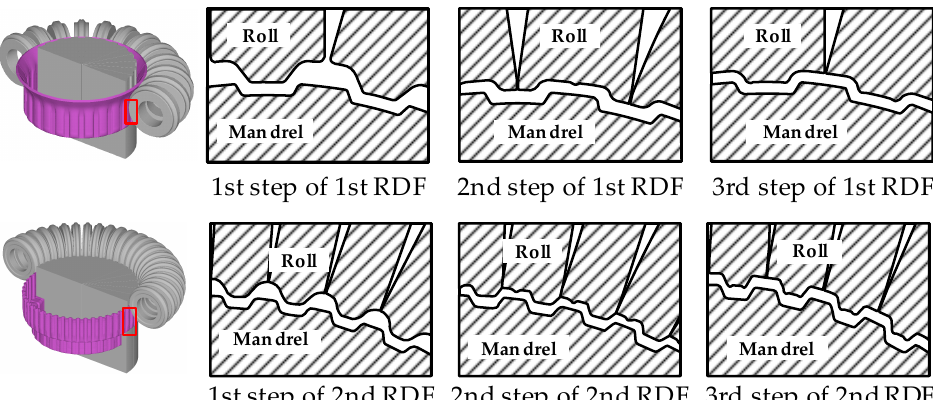
Figure 2. The schematic drawing multi-stage roll die forming (RDF) process, ( a ) 1st stage of RDF and ( b ) 2nd stage of RDF.